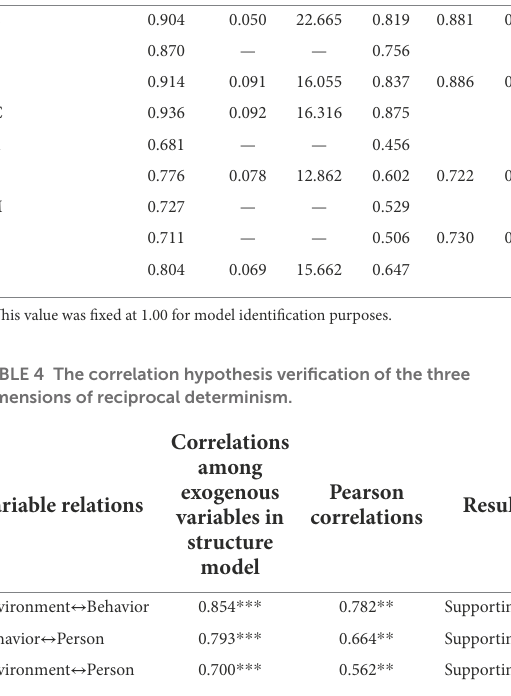
TABLE 3 Summary of model parameter estimates and the reliability and validity results. Measurement indicators